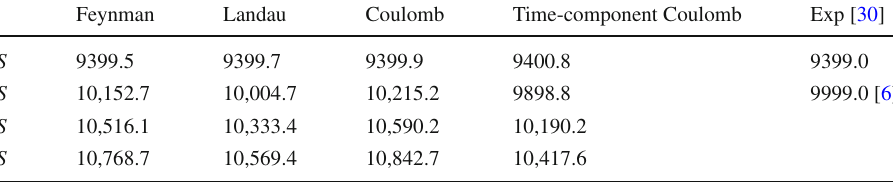
Table 7 Mass spectra of η b ( nS